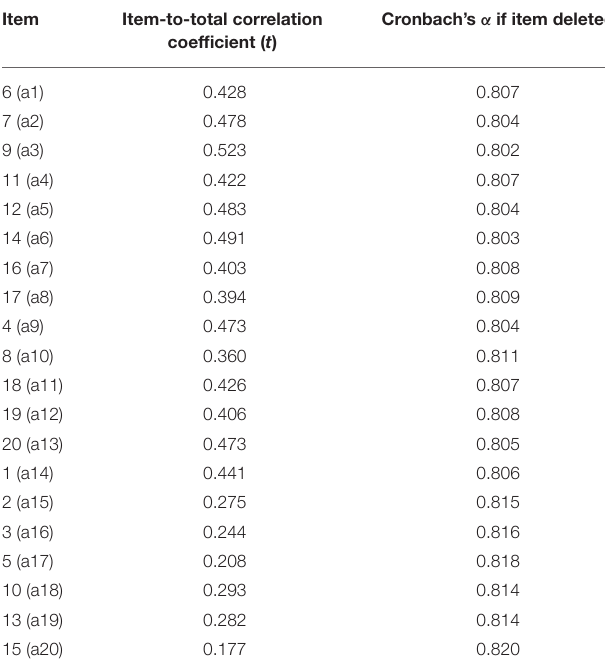
TABLE 3 | Cronbach’s alpha coefficient if the item was deleted and item-total correlation.